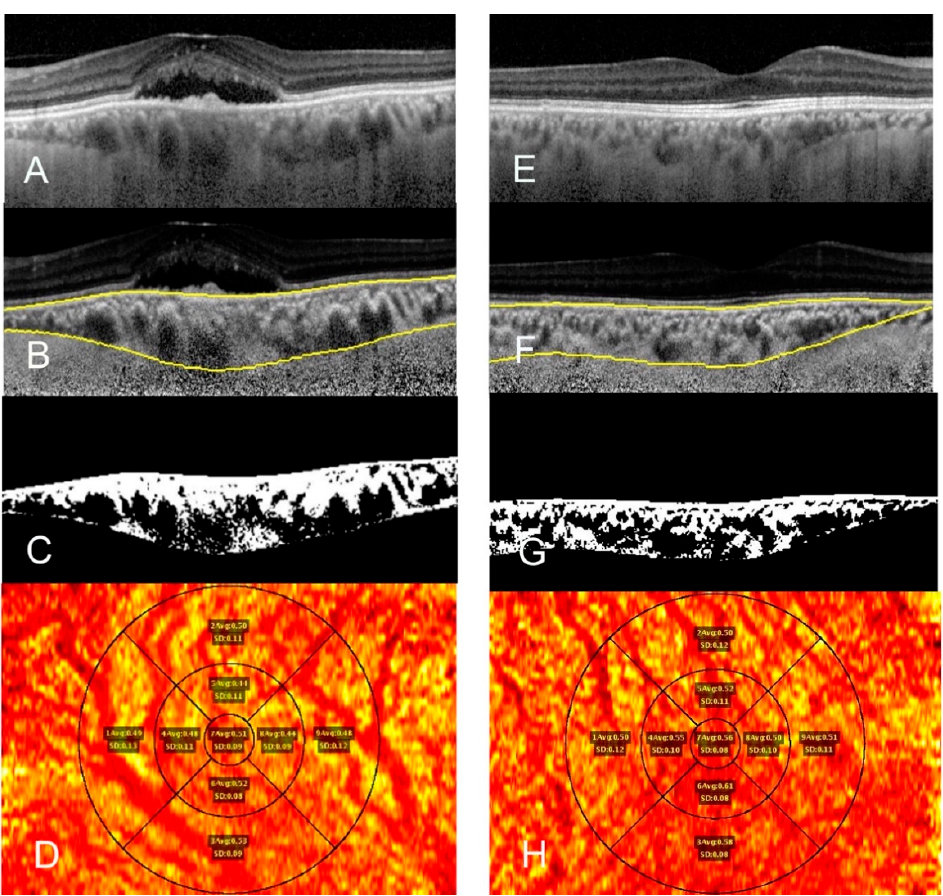
Figure 1. Comparison of choroidal vascularity index mapping of a 52-year-old female showing optical coherence tomography raw image of central serous chorioretinopathy (CSCR) eye ( A ) and fellow eye ( E ), choroid segmentation using an automated algorithm after shadow compensation of CSCR ( B ) and fellow eye ( F ); and binarized image ( C , G ). ETDRS grid-based choroidal vascular index (CVI) map images shows mean and standard deviation of CVI at the center, the 3-mm zone, and the 6-mm zone in each quadrant of CSCR eye ( D ) and fellow eye ( H ). ( D , H ) Red color shows choroidal vessels and yellow color shows choroidal stroma.